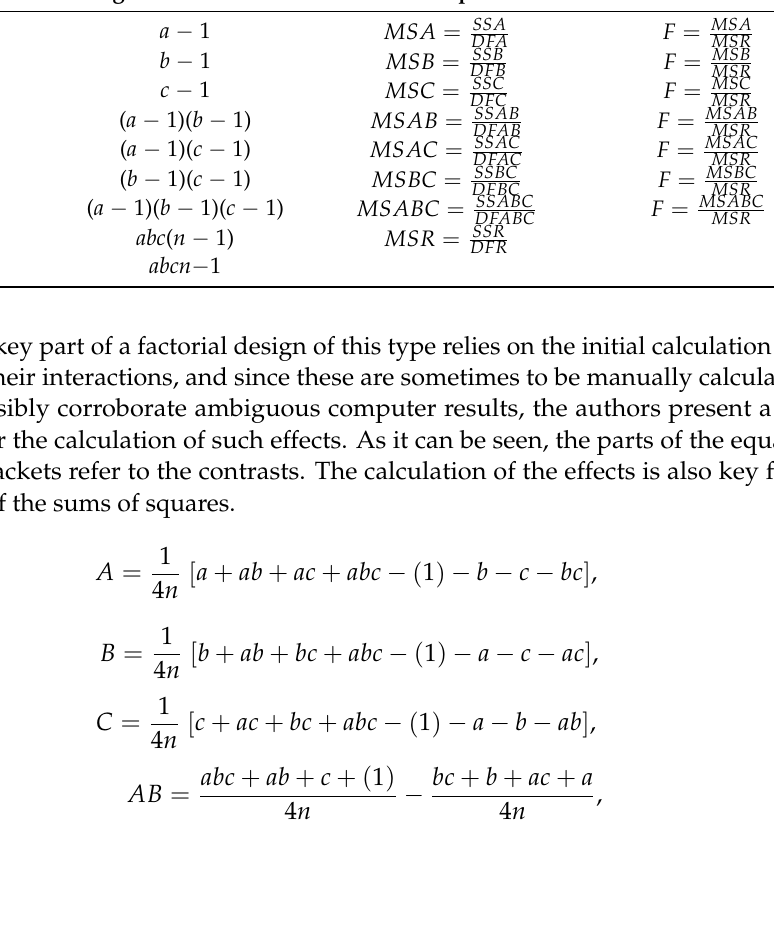
Table 3. Analysis of variance for the general case of the three-factor model with fixed effects. Source of Variation Sum of Squares Degrees of Freedom Mean